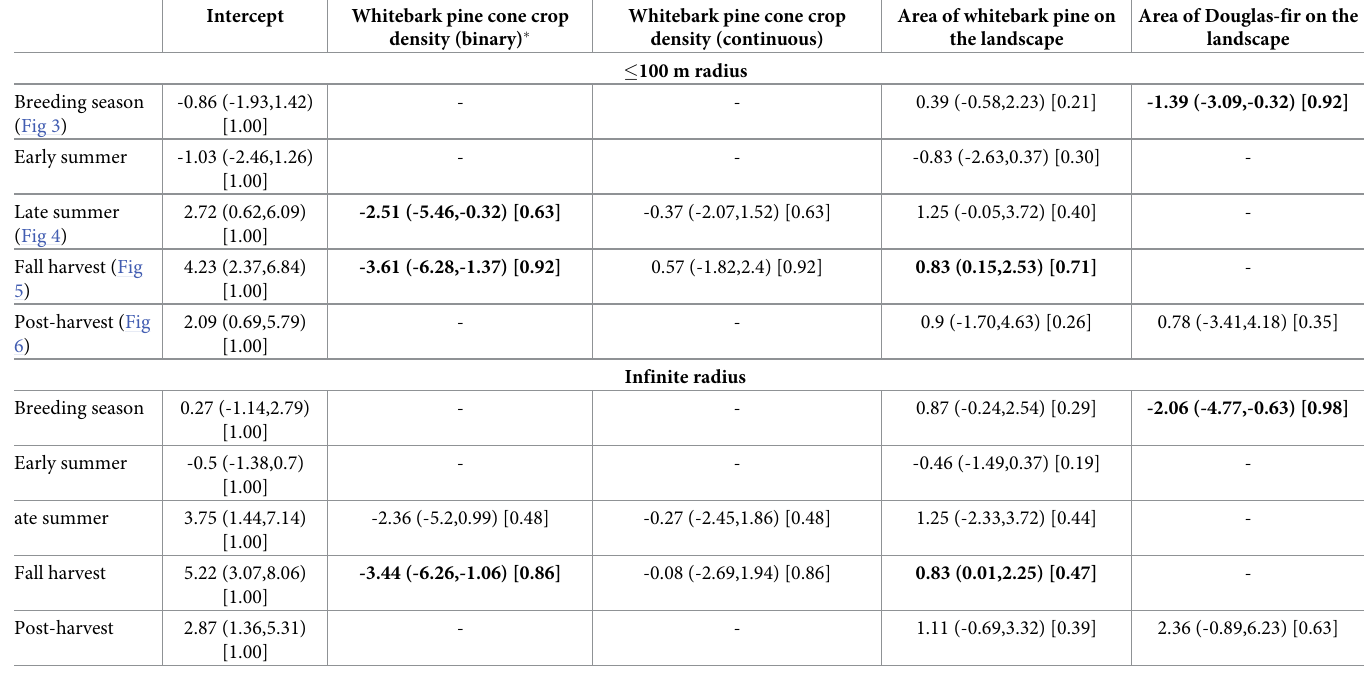
Table 6. Model averaged, or conditional, parameter estimates ( ± 95% credible intervals), and conditional posterior support for each parameter in the occupancy model. Posterior distribution of stage-specific parameter estimates, and conditional posterior support which shows how important is each covariate in predicting occur- rence as compared to other parameters in the model set (in square brackets). Dashes indicate stages in which effects were constrained to be 0 (i.e. were not considered). Bolded results indicate that the CI’s exclude 0 (i.e. there is an effect). Intercept Whitebark pine cone crop Whitebark pine cone crop Area of whitebark pine on Area of Douglas-fir on the density (binary) � density (continuous) the landscape